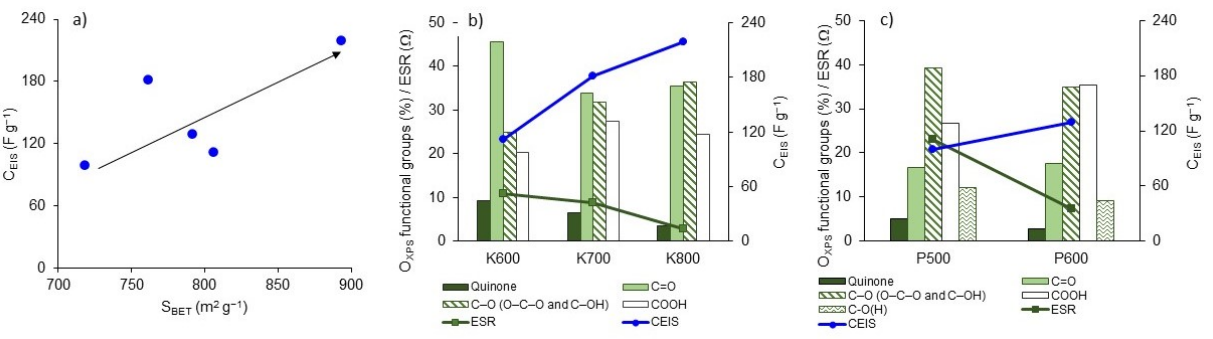
Figure 9. Relationship of gravimetric capacitance (C EIS ) to ( a ) S BET , ESR and oxygen superficial functional groups of ( b ) BNCA-K and ( c ) BNCA-P.